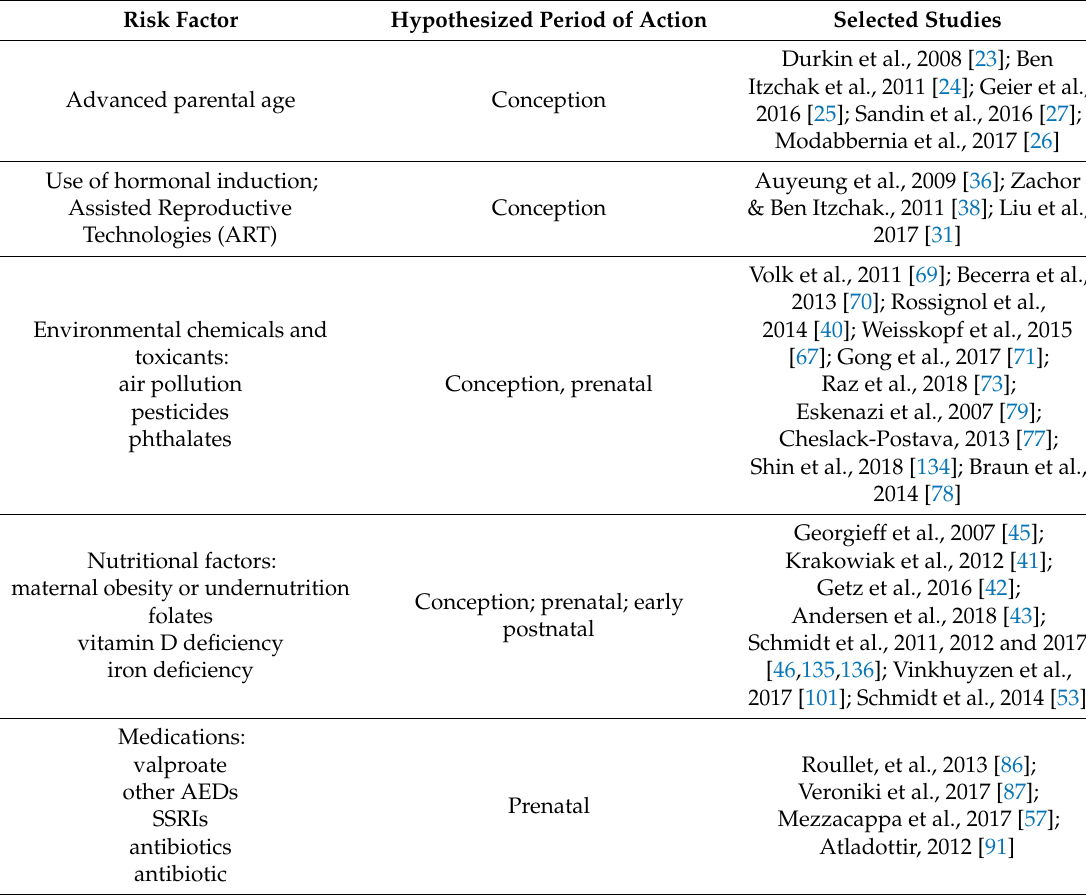
Table 1. Possible environmental risk factors for Autism Spectrum Disorder